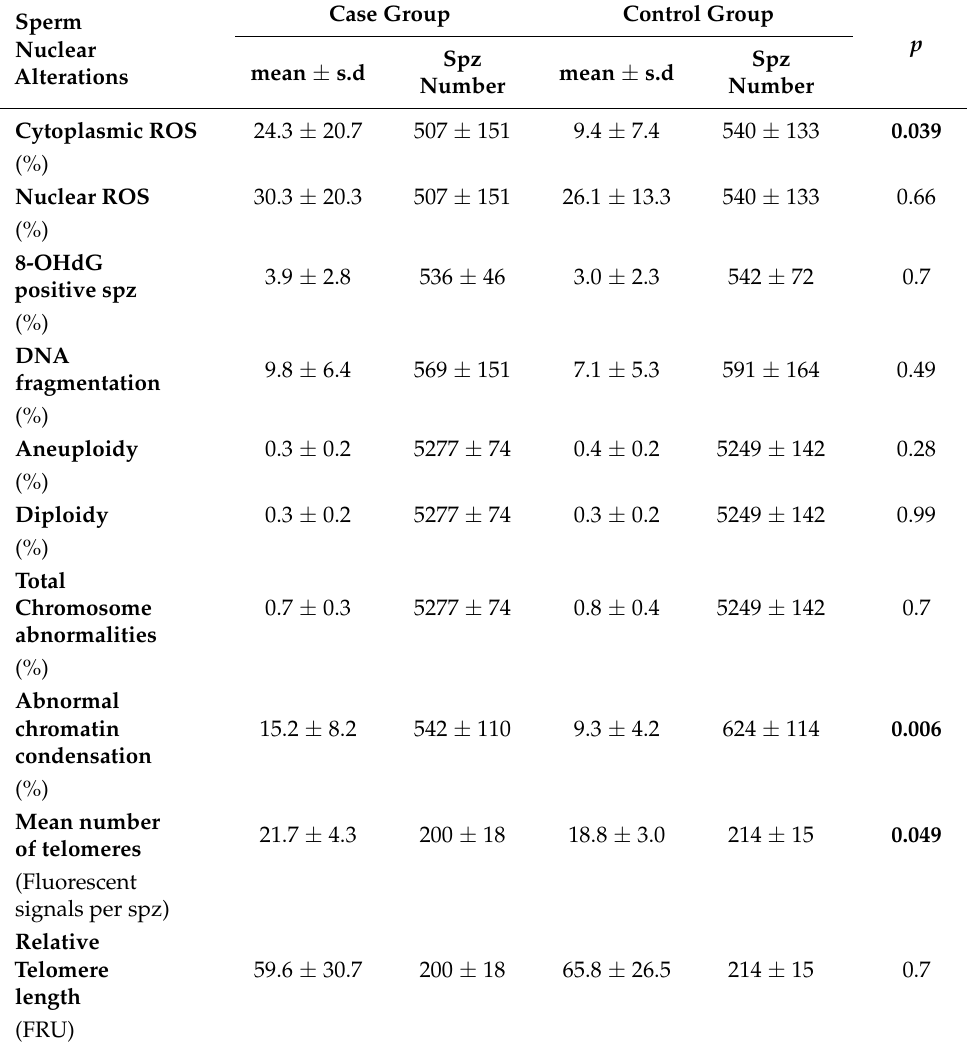
Table 3. Sperm nuclear alterations observed in case and control